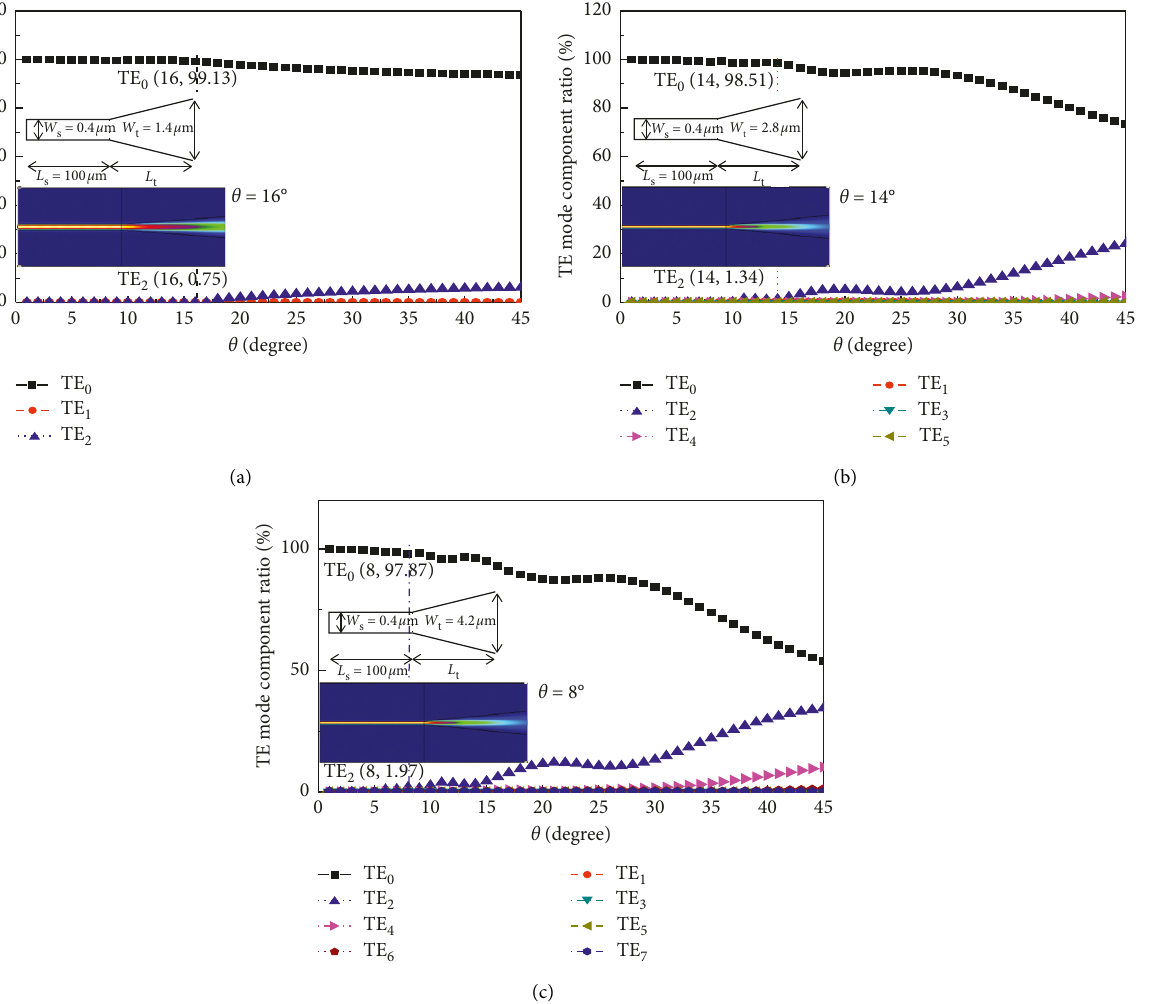
Figure 6: The width of a linear tapered waveguide (a) W W mmi � 12 μ m; with divergence angle θ of a linear tapered waveguide ranging from 1 ° to 45 ° . The maximum divergence angle for linear tapered waveguide is achieved at θ � 16 ° /14 ° /8 ° for W t � 1.4 μ m/2.8 μ m/4.2 μ m,